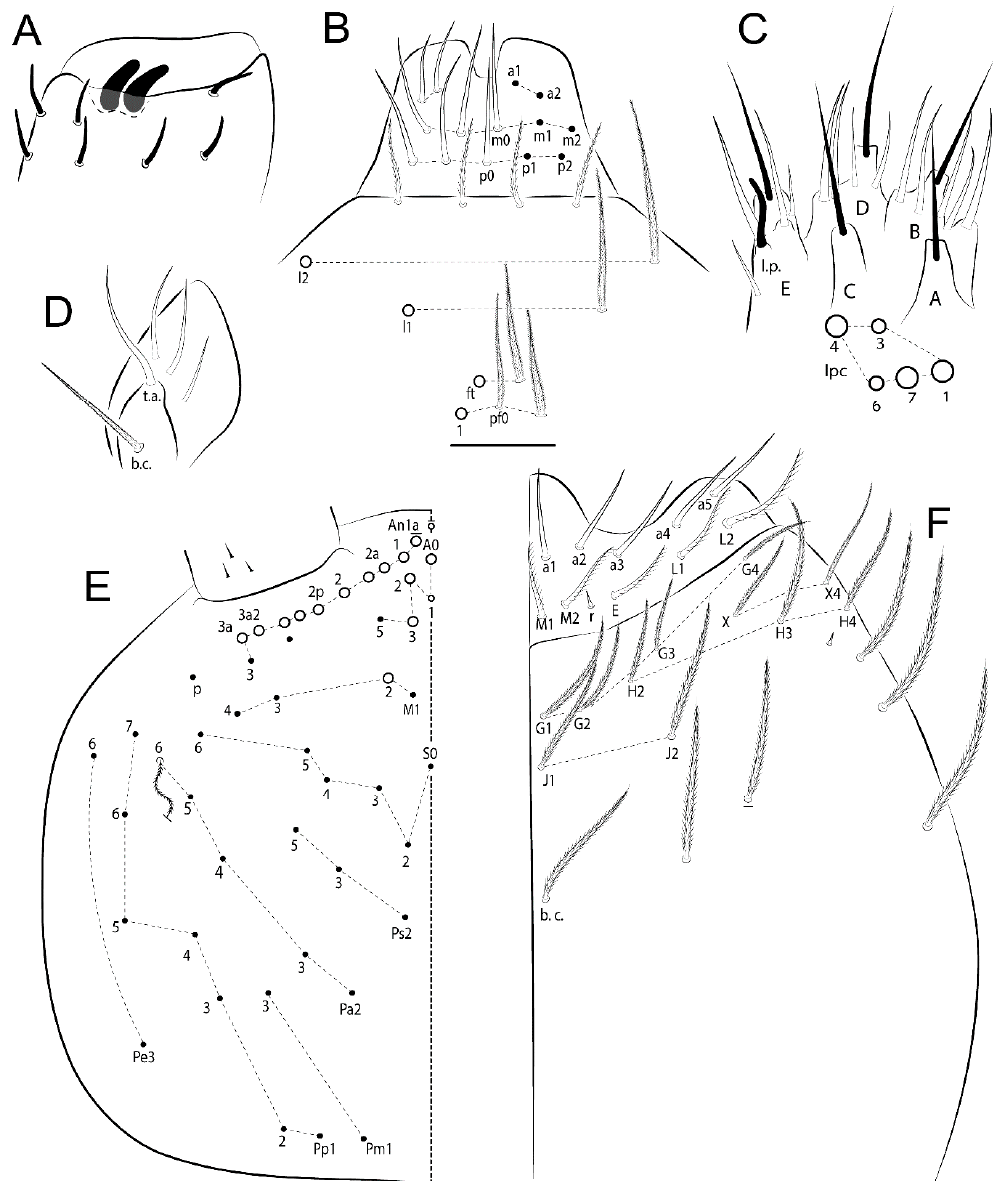
Figure 49. Pseudosinella marianensis sp. nov.: head. ( A ) Ant III apical organ (ventro-lateral view); ( B ) chaetotaxy of clypeus, prelabrum, and labrum; ( C ) labial papillae (H omitted) plus proximal chaetae (left side); ( D ) maxillary palp and sublobal plate (left side), minute appendage omitted; ( E ) head dorsal chaetotaxy (left side); ( F ) basomedian and basolateral labial fields and complete postlabial chaetotaxy (right side).